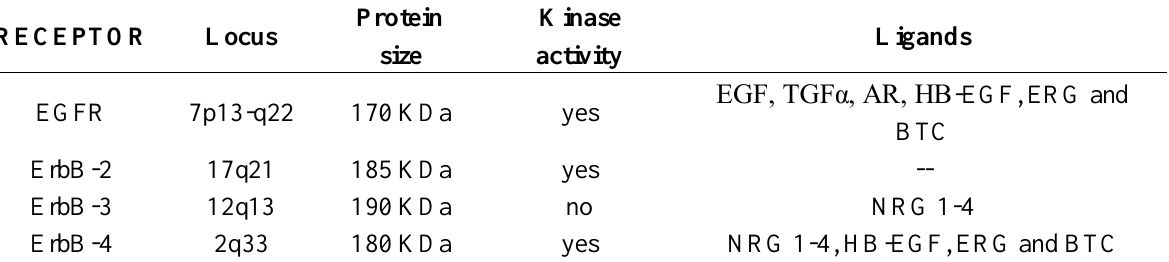
Table 2. ErbB family members and their